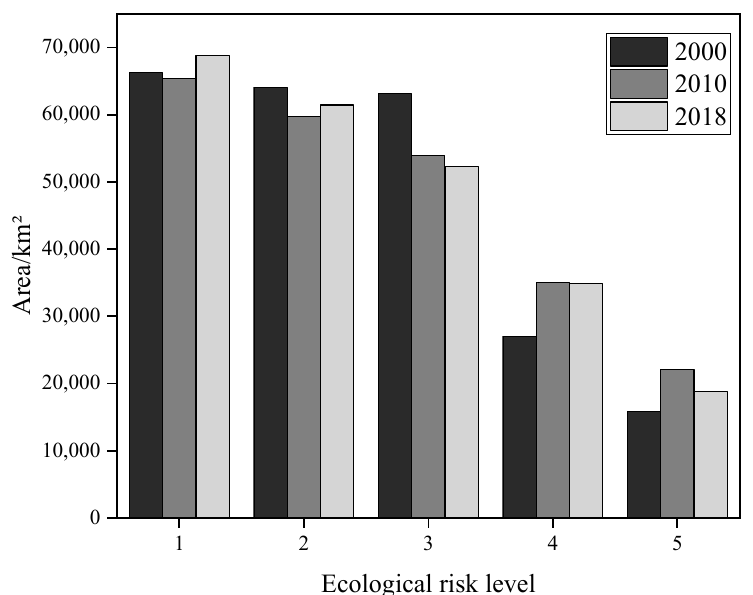
Figure 4. Area map of ecological risk level in Guangxi. Note: 1, 2, 3, 4, and 5 represent low risk, low – medium risk, medium risk, medium – high risk, and high risk, respectively.